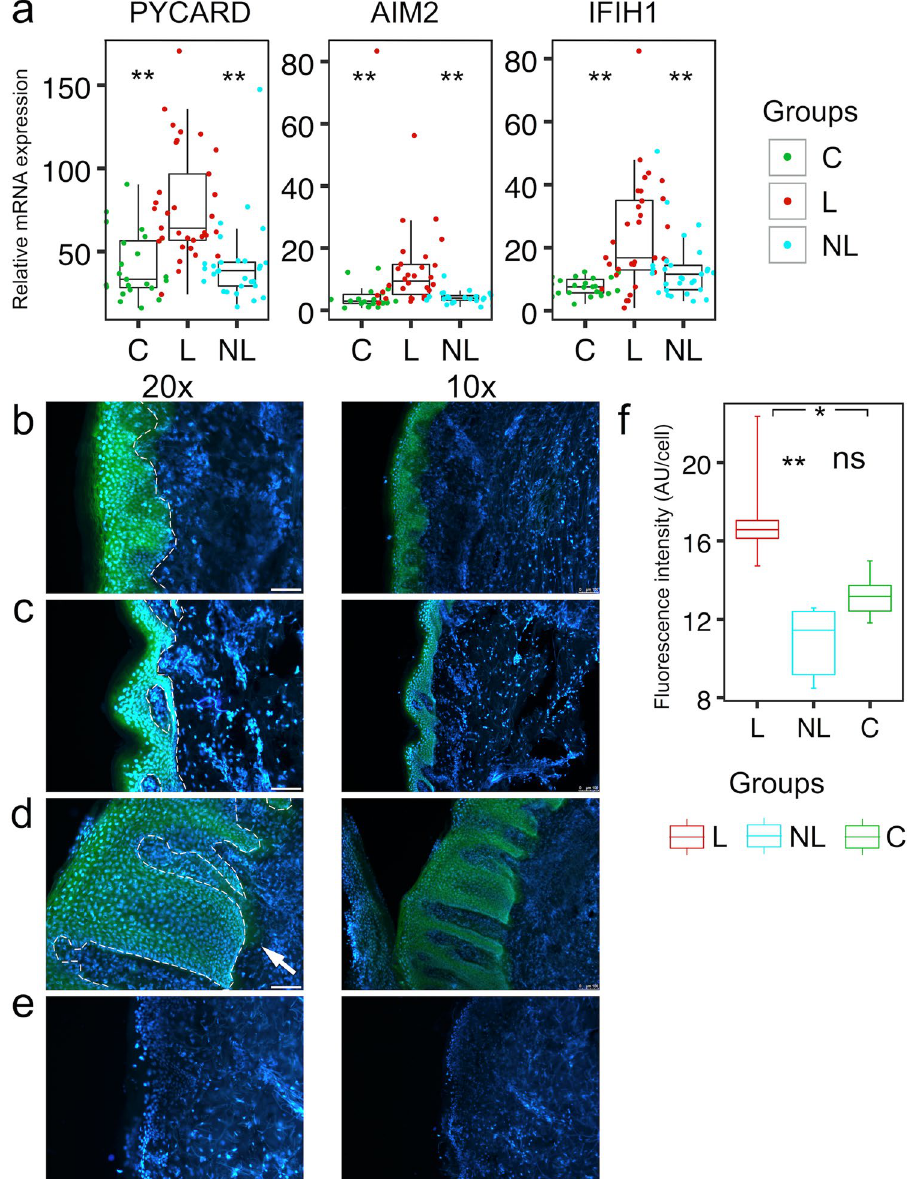
Figure 3. Innate receptors’ upregulation and inflammasome activation in psoriatic lesions. ( a ) mRNA expression of genes encoding innate receptors relative to ACTB in skin biopsy samples obtained from lesional (L) and non-lesional (NL) skin of psoriasis patients and from age-matched control individuals (C). The description of the box-and-whiskers and stars can be found in the legend of Fig. 1. ( b–e ) Fluorescence microscopic images illustrate caspase-1 activation as detected with FAM-FLICA Assay Kit (green) in control skin ( b ) psoriatic non-lesional skin ( c ) or psoriatic lesional skin ( d ) biopsy frozen sections with DAPI for counterstaining cell nuclei. ( e ) Represent control slides. White bars in 20x images represent 75 µ m. White dotted lines indicate the basal membrane. ( f ) Green fluorescence intensity was measured from the slides in fixed areas of stratum spinosum (from slides of two different individuals and 2–3 different areas per slide) and divided by the number of cells per the